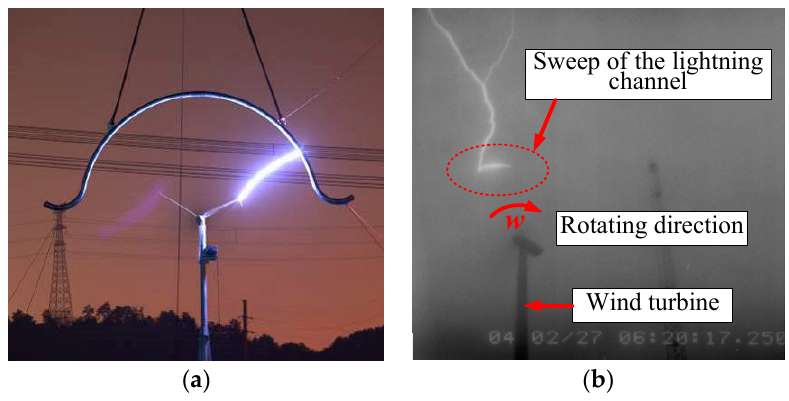
Figure 7. The typical discharge process of rotating wind turbine. ( a ) the breakdown path of scaled model test in 2 m air gap; ( b ) natural lightning striking rotating wind turbine blades in Japan.